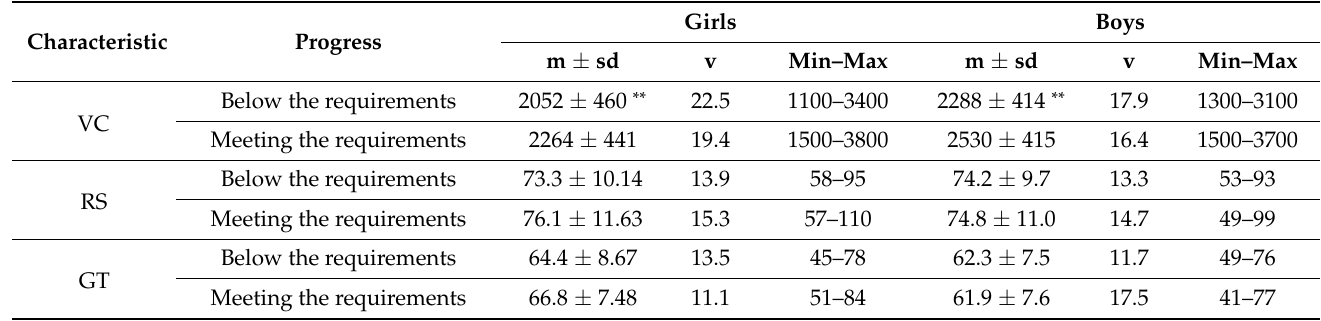
Table 5. Functional characteristics of 10-year-old children in swimming progress groups.